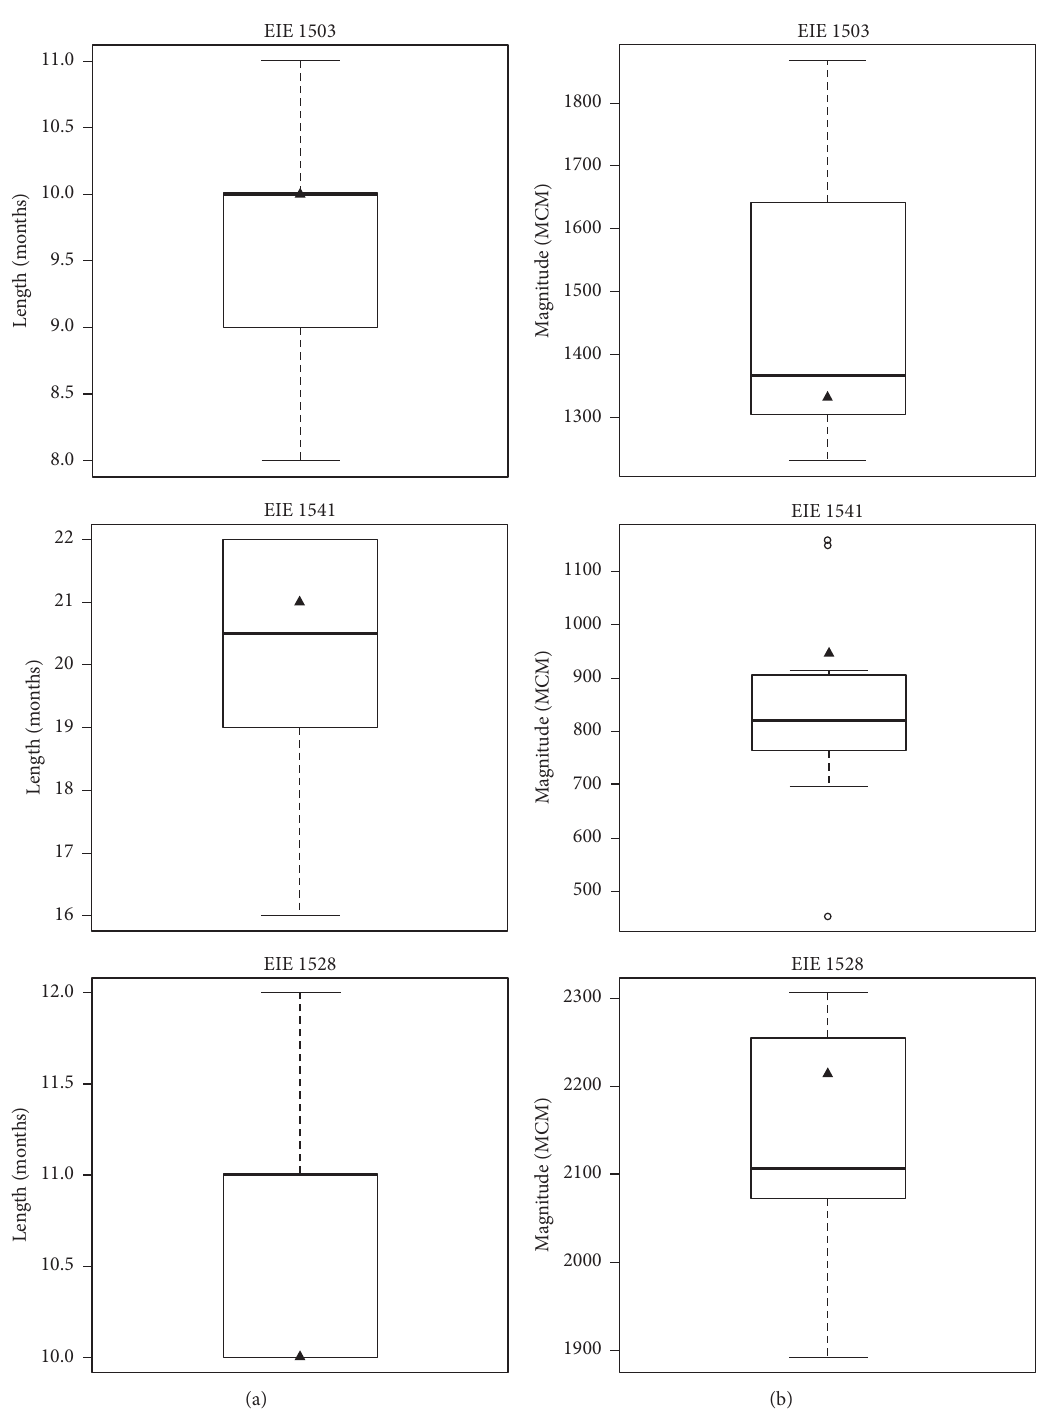
Figure 6: Boxplots of length (a) and magnitudes (b) of maximum monthly droughts from the temporal approach. The triangle denotes the observed